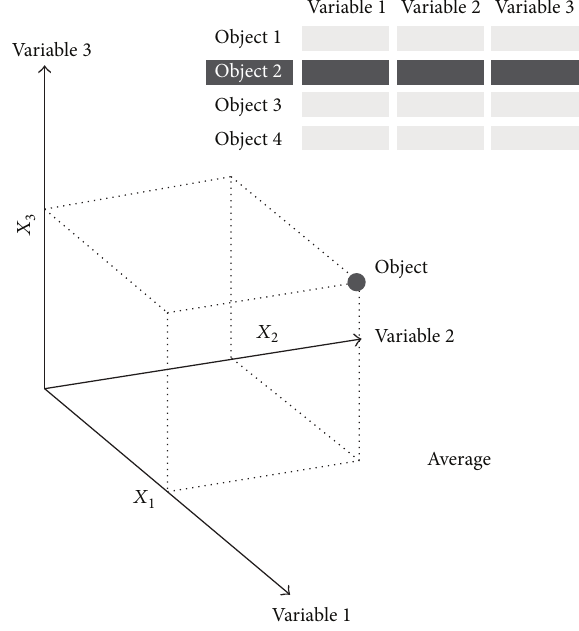
Figure 3: Illustration of principal component analysis